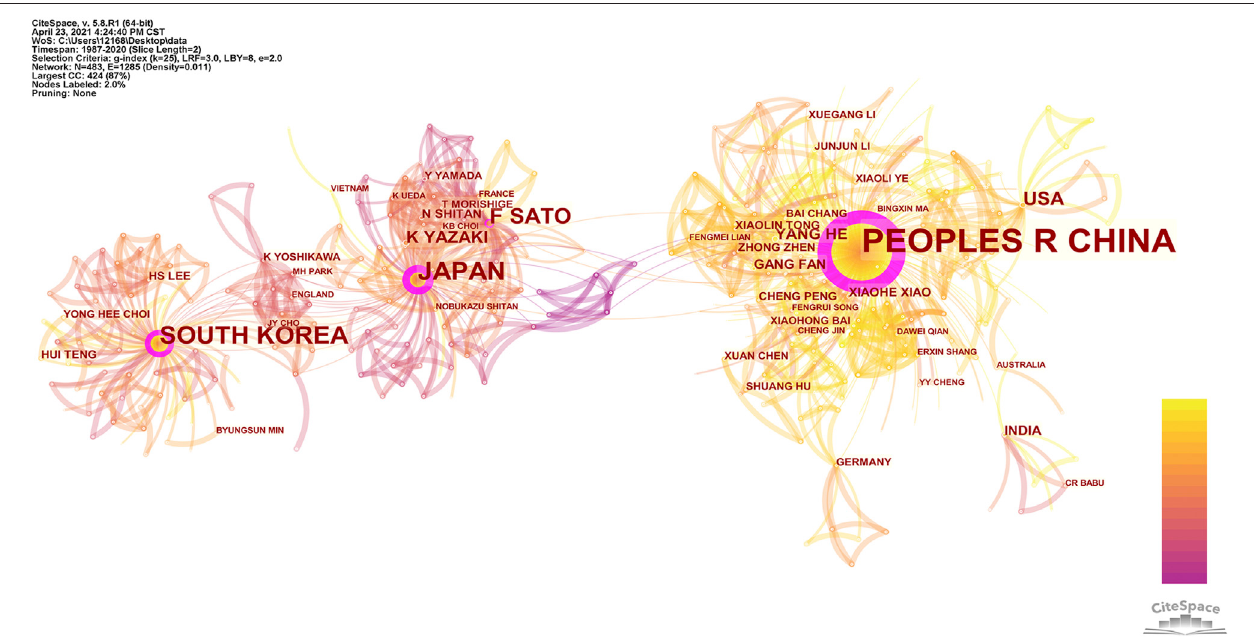
FIGURE 5 | Countries/regions and authors collaboration network of Coptis research.